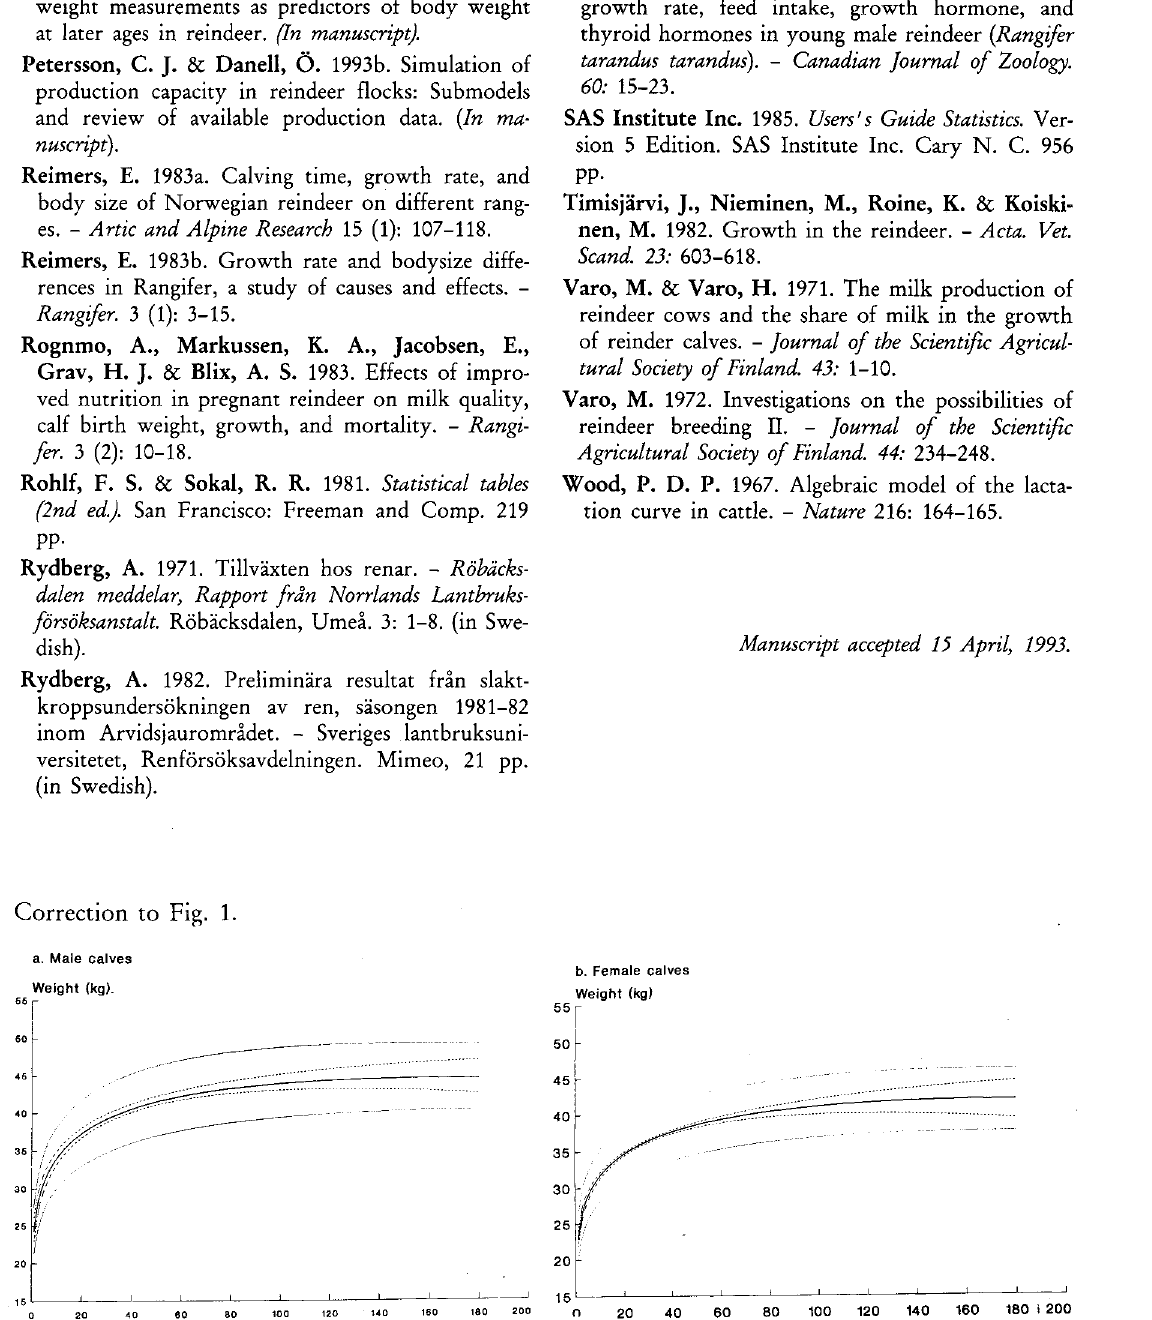
Fig. 1. Average growth curves and ranges for one standard deviation between years (—) and within year (....),